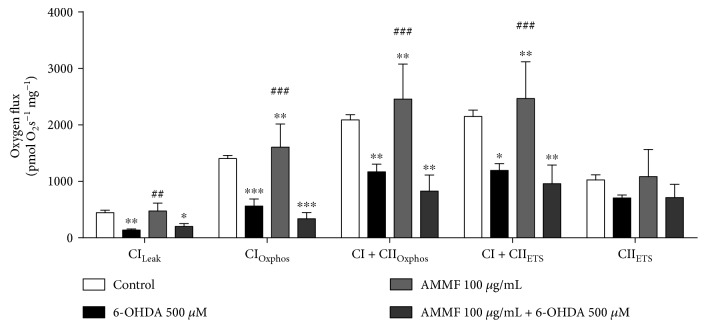
O2 flux measured in the mitochondria of cortex homogenate exposed to 6-OHDA and/or A. microcarpum. Mitochondrial function is presented with the abbreviation(s) of the complex(es) involved followed by the state of respiration measured in the presence of glutamate + malate (CILEAK), +ADP (CIOXPHOS), +succinate (CIIOXPHOS), +FCCP (CI + IIETS), +rotenone (CIIETS). Antimycin A was used to correct for residual O2 consumption. Results are means ± SEM for 4 different preparations. ∗p < 0.05, ∗∗p < 0.001, and ∗∗∗p < 0.0001 different from control group. ##p < 0.001 and ###p < 0.0001 when compared to 6-OHDA group.